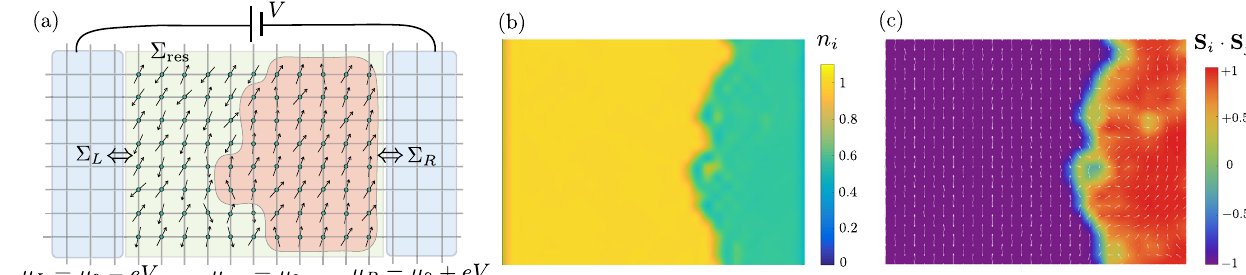
Fig. 3 Nonequilibrium Green ’ s function (NEGF) calculation for the s-d model driven by an external voltage. a Schematic diagram of the driven s-d model in a metal-insulator-metal capacitor structure. The central region is described by the square-lattice s-d Hamiltonian in Eq. (10), while the two electrodes at left and right ends are shown here as modeled by simple square-lattice tight-binding model. An external voltage is applied to the two electrodes, giving rise to a difference in chemical potentials μ L / R = μ 0 ∓ eV /2, where μ 0 is the chemical potential of the background reservoir. Panals b and c show the on-site electron number n i and nearest-neighbor spin-spin correlation S i ⋅ S j , respectively, of a snapshot during the voltage-induced insulator-to-metal transition simulated by the NEGF-LLG method. The size of the square lattice is 30 ×